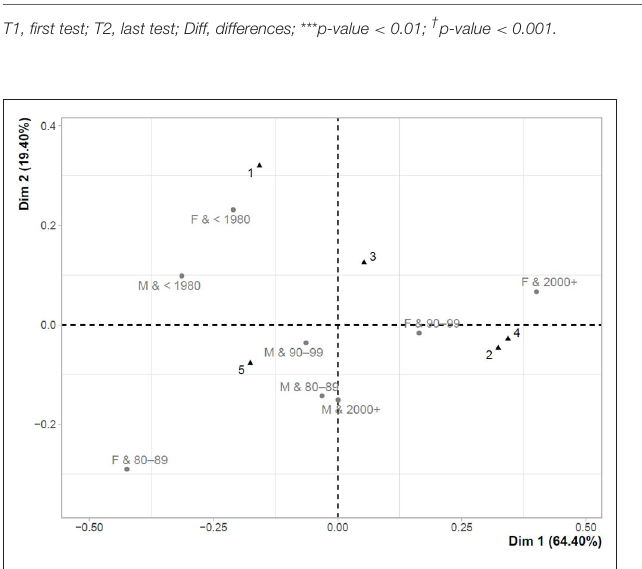
FIGURE 4 | Correspondence map for T1–perception of doubts about the accuracy of test results and gender-age characteristics.